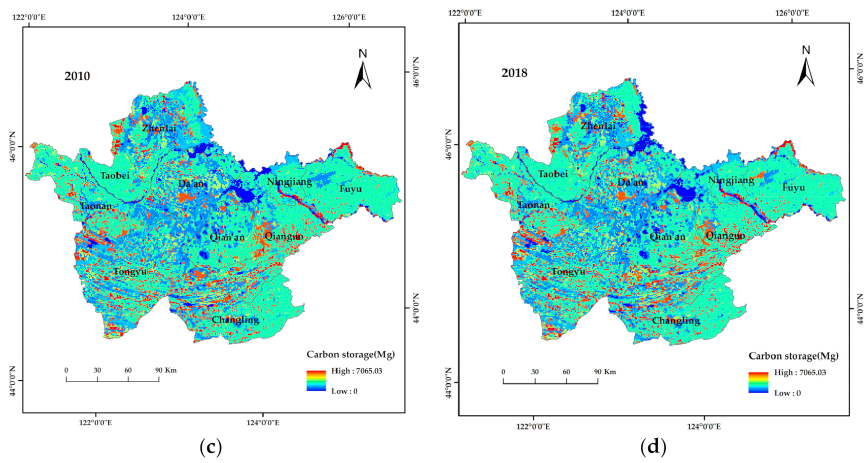
Figure 4. Spatial distribution of carbon storage in western Jilin Province from 1990 to 2018.